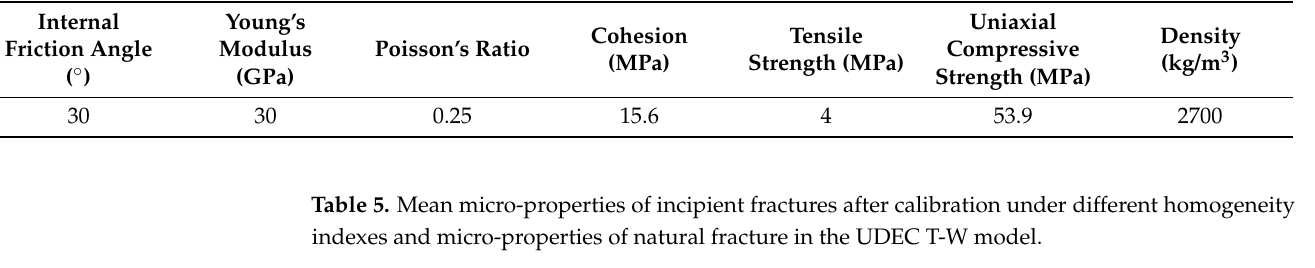
Table 4. Mechanical properties in Zangeneh et al.’s numerical simulation [38].